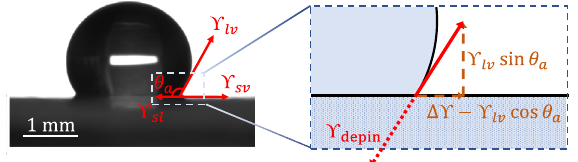
FIG. 5. The depinning force at the contact line at the advancing contact angle. This opposes the surface-tension forces from ϒ lv , ϒ ϒ sv , and sl . Note that, in general, this is not parallel to the liquid surface at the contact